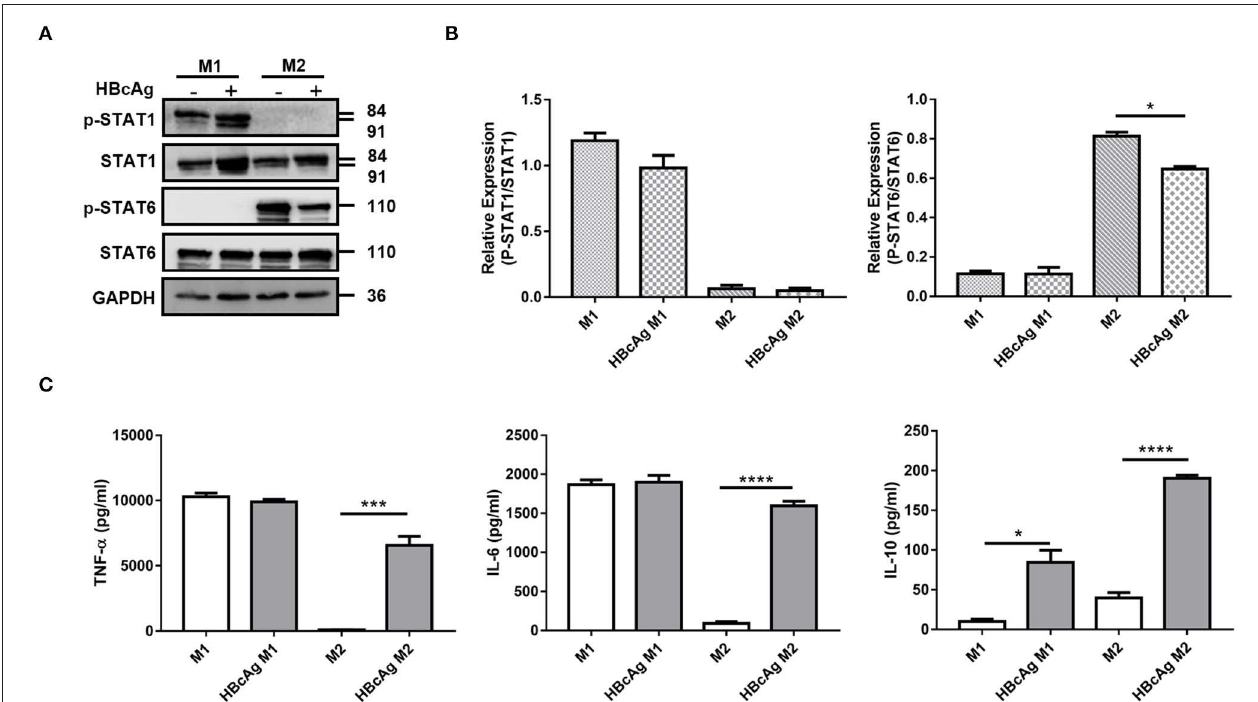
FIGURE 3 | HBcAg retrieved the production of inflammatory cytokines by M2 macrophages and inhibited M2 phenotype correlated with STAT6 pathway. (A,B) After being stimulated with GM-CSF or M-CSF for 6 d, M0–M1 and M0–M2 unpolarized M Φ were incubated with LPS/IFN- γ or IL-4 for further differentiation. After another 24h incubation, polarized M1 or M2 M Φ were stimulated with 10 µ g/ml HBcAg or an equal volume of PBS for another 30min. The protein levels of STAT1, p-STAT1, STAT6, and p-STAT6 were analyzed by Western blot. (A) Representative figures and (B) cumulative densitometry quantification for p-STAT1 and p-STAT6 expression normalized to STAT1 and STAT6, respectively. (C) Supernatants of polarized M1 and M2 M Φ stimulated with HBcAg or PBS were collected to measure TNF- α , IL-6, and IL-10 productions by ELISA. Experiments in (A,B) were repeated at least three times. Data were analyzed using a paired Student’s t -test. Results are shown as the mean ± SEM ( A,B , n = 3; C , n = 9–11). * p < 0.05, *** p < 0.001, **** p <